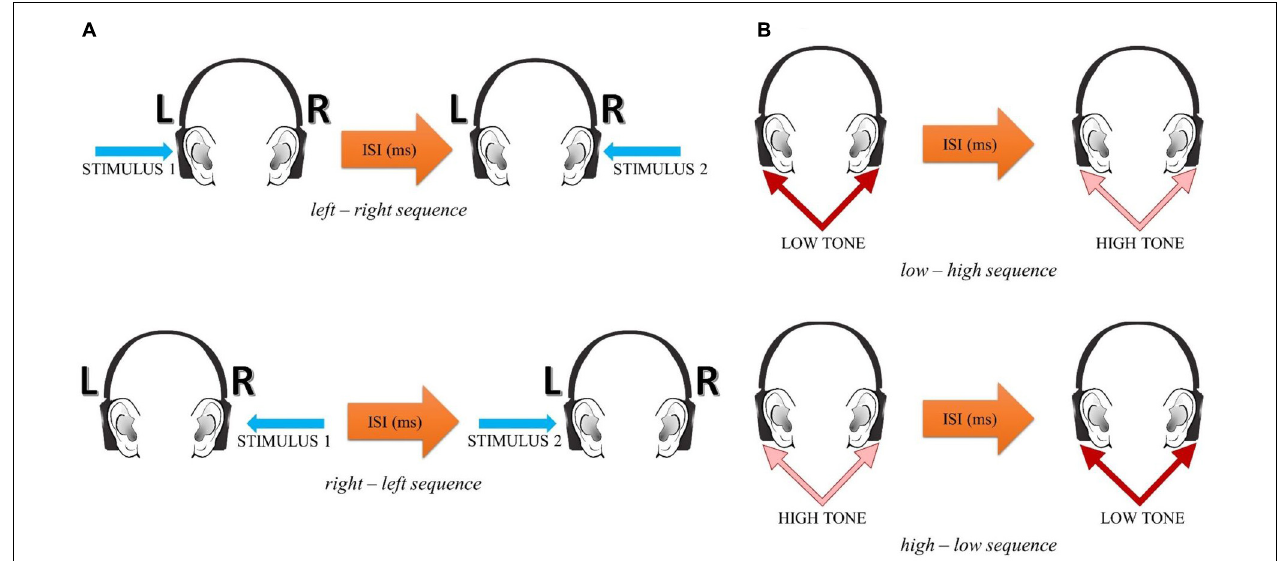
FIGURE 1 | The experimental setup in the spatial (A) and spectral (B) tasks.